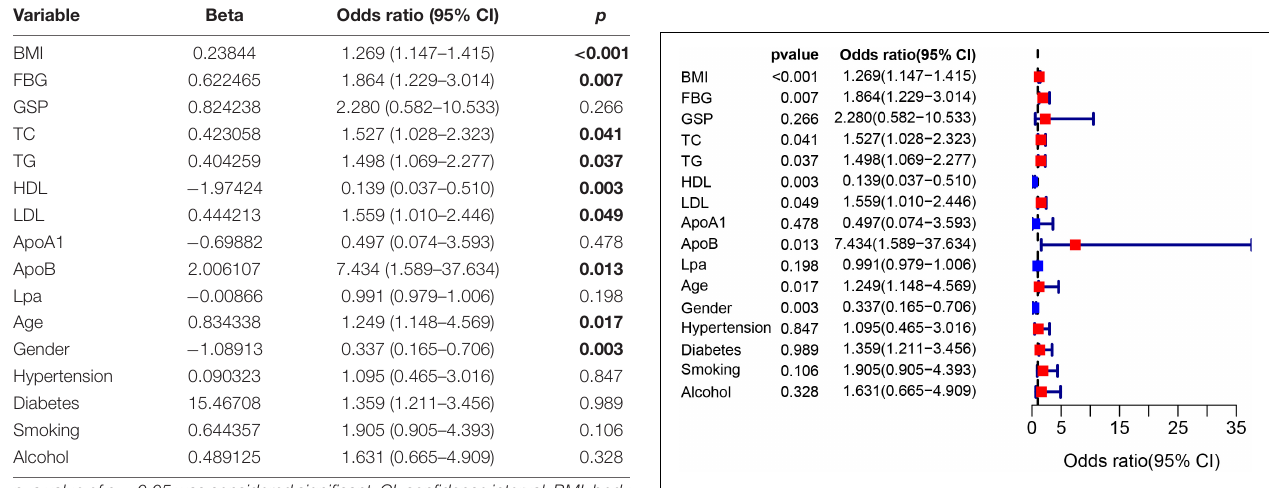
greater than 1 and less than 1,